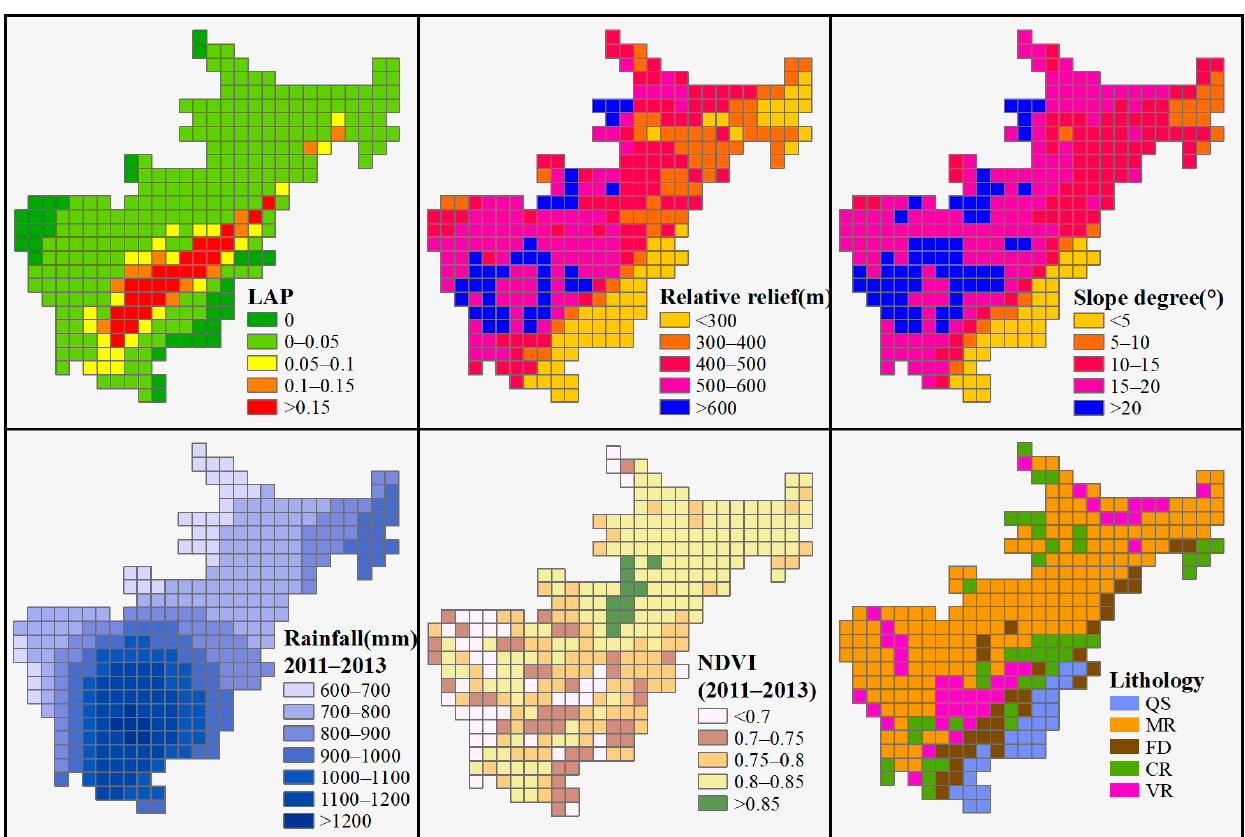
Figure 3. Grading results based on a 10×10 km grid of the controlling factors .